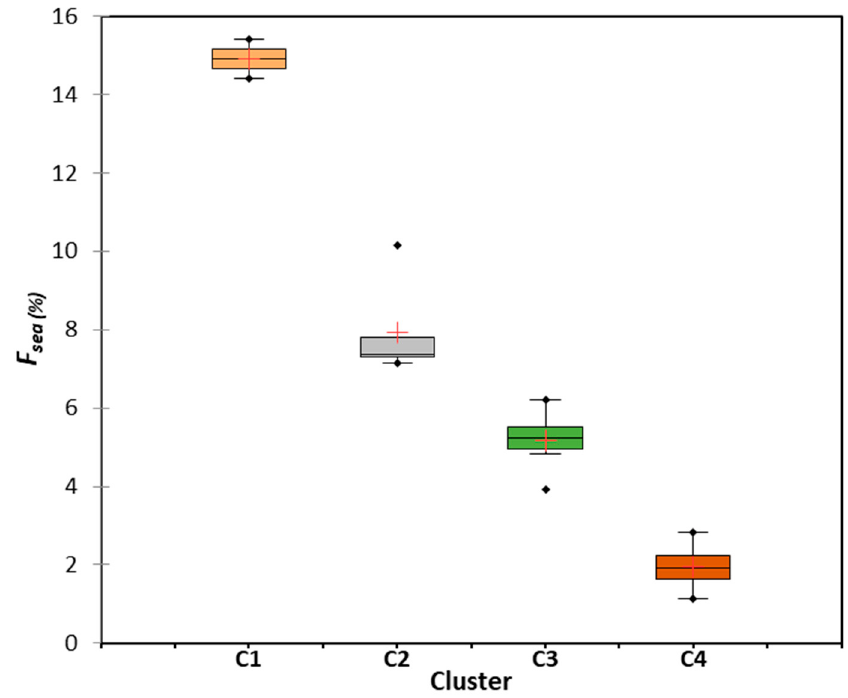
Figure 6. Box plots showing statistics values of the f sea for each cluster (C1, C2, C3, and C4) (+ represent the median values) .